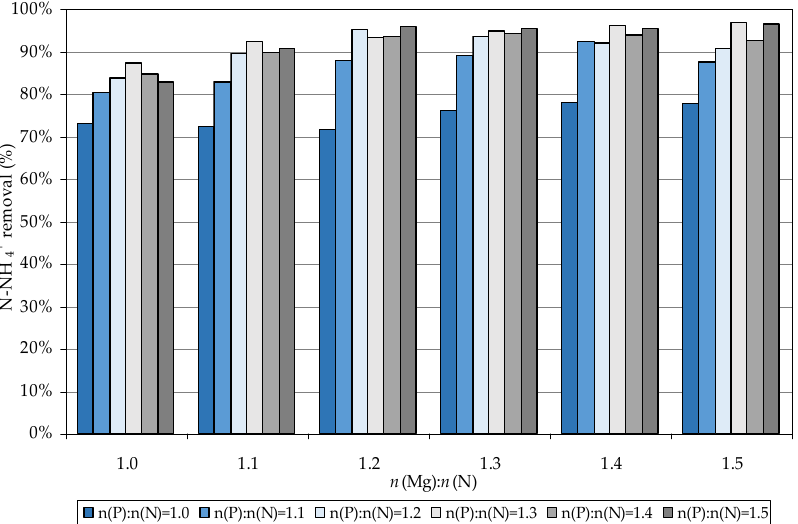
Figure 1. Ammonium removal during the tests conducted by using industrial grade reagents.